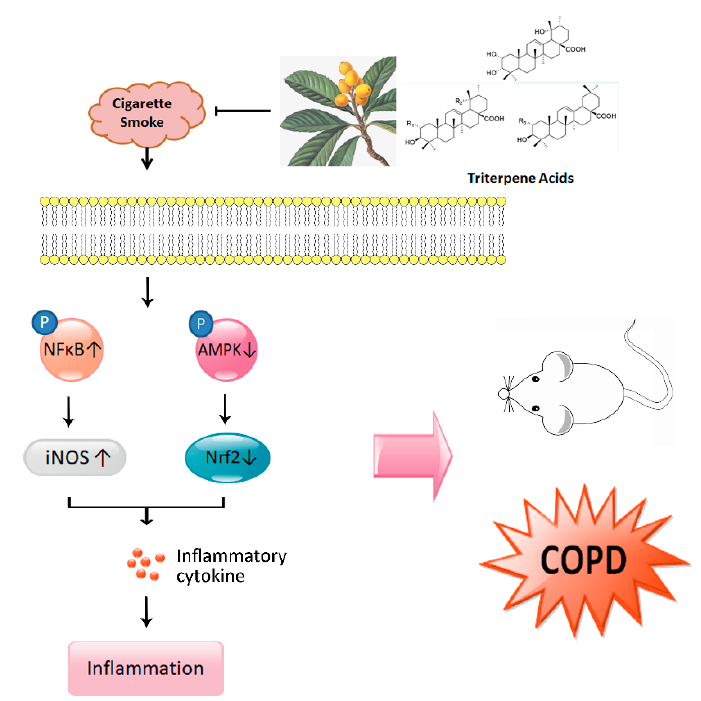
Figure 7. Schematic illustration of major points of conclusion.